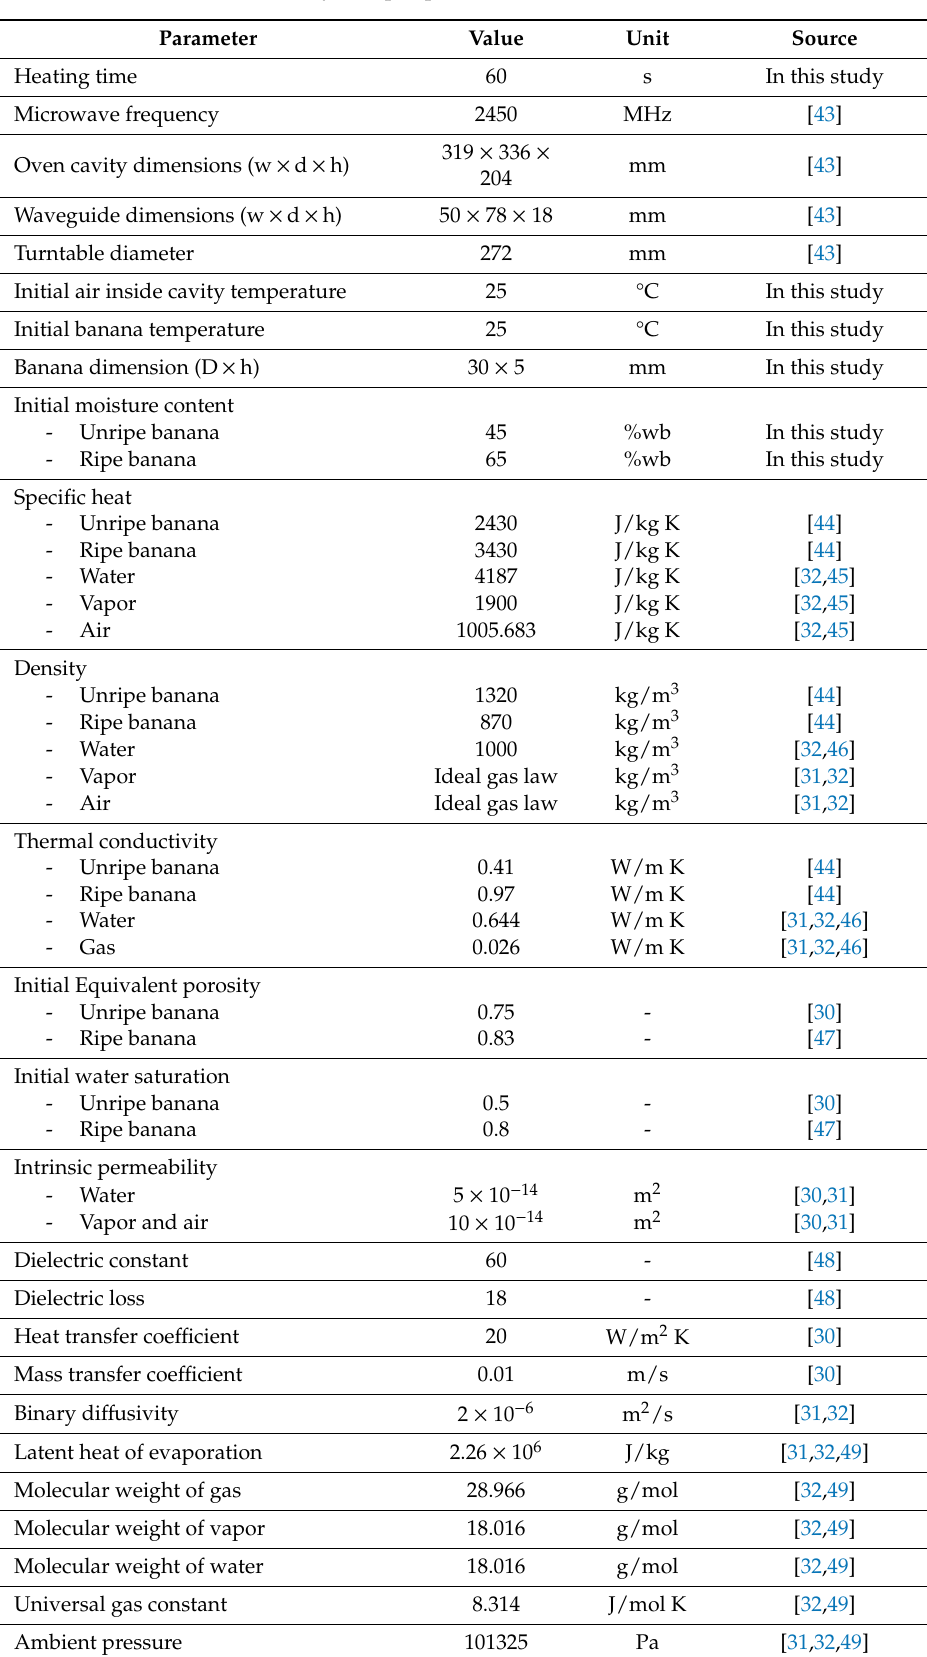
Table 1. Summary of input parameters used in the